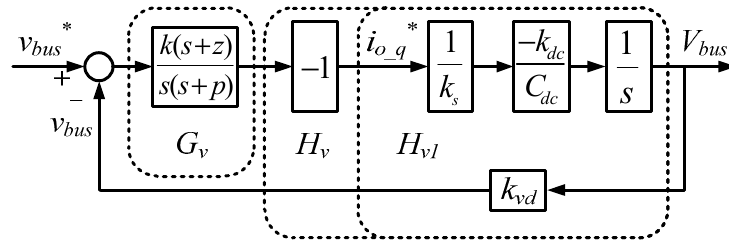
Figure 8. Outer DC bus voltage control loop (* indicates commands).